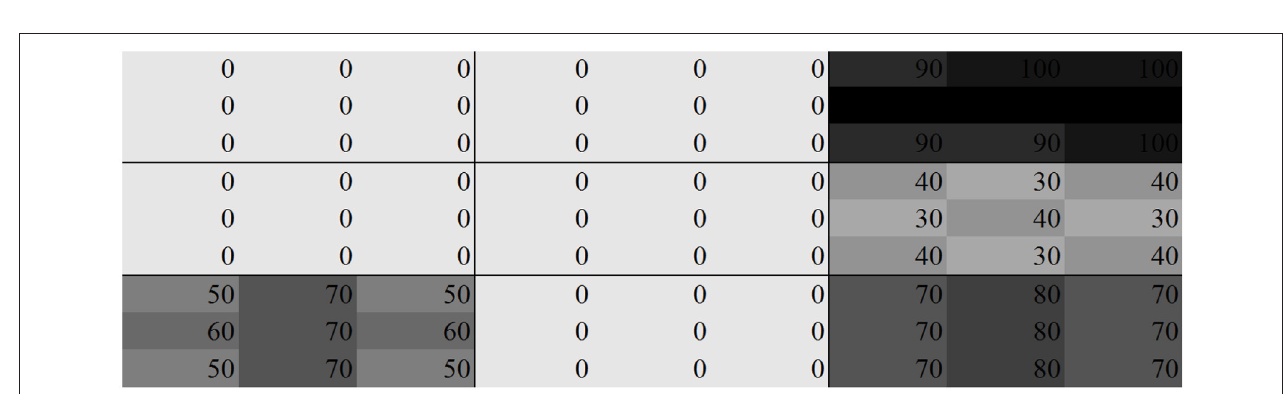
FIGURE 7 | Distribution of illuminance around the urban region where a limit is placed on number of